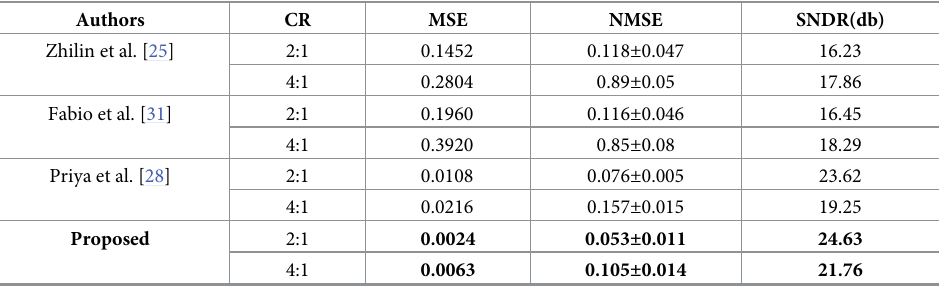
Table 1. Quantitative measures for sparse signal recovery of EEG